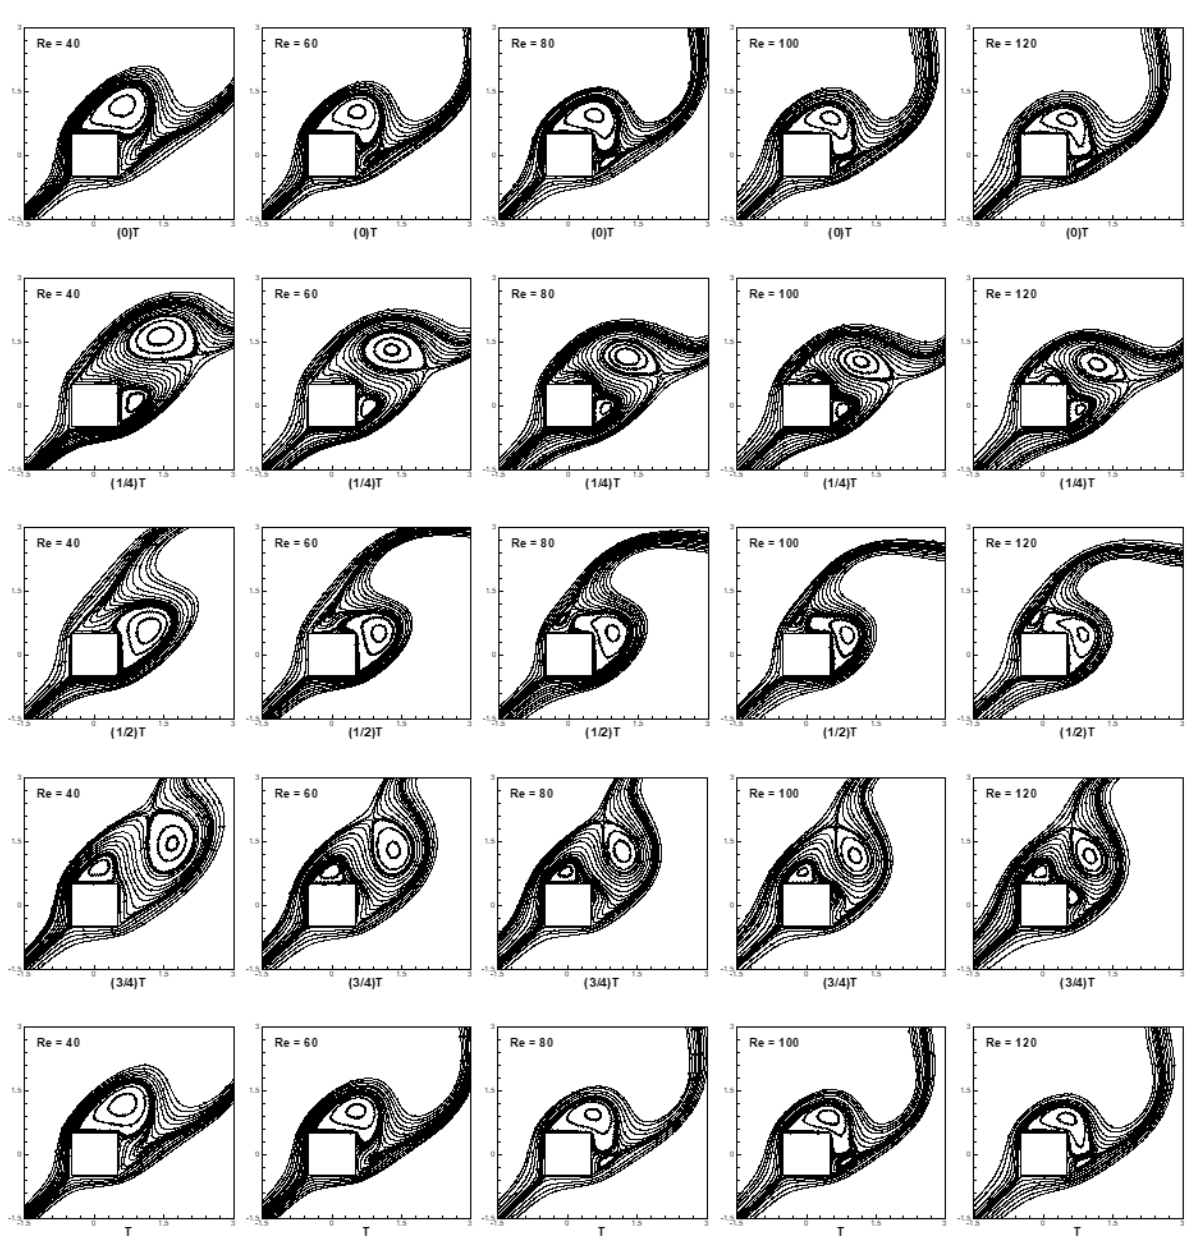
Figure 3. Instantaneous streamline patterns at α = 45 °, Ri = 0 and 40 ≤ Re ≤ 120 for five successive moments of time that span the whole period.